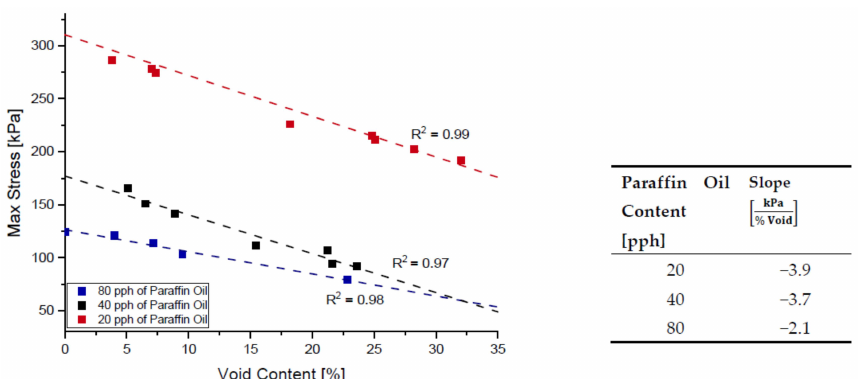
Figure 22. The influence of paraffin oil content on σ relax of NR blend with 1.5 pph of sulfur.